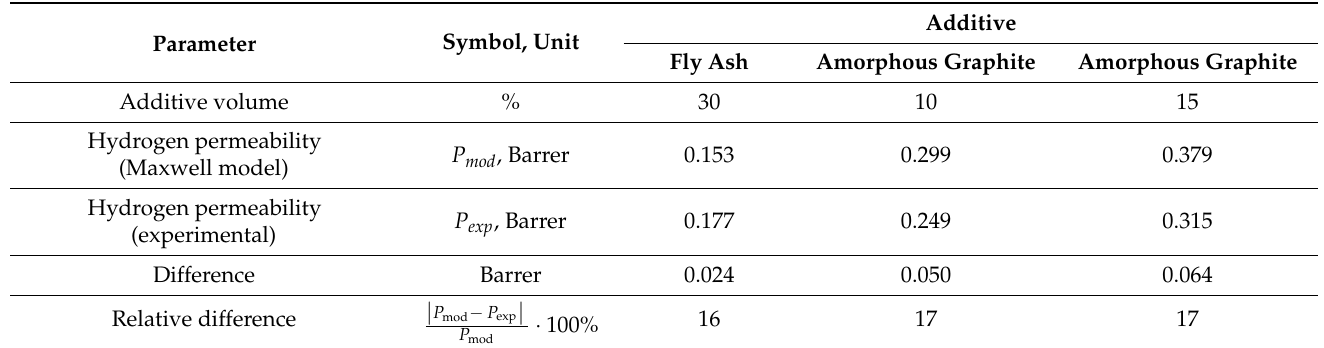
Table 3. Hydrogen permeability obtained with Maxwell model.